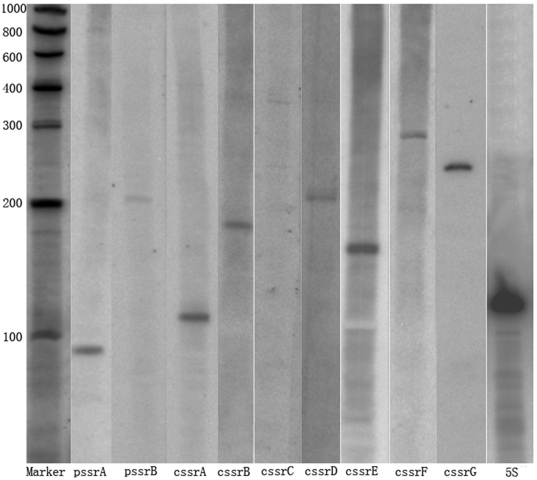
Detection of small RNAs by Northern blot analyses.Northern blots were performed with total RNA using strand-specific probes as described in Materials and Methods. The size of RNA markers is indicated on the left. 5s RNA was used as control.